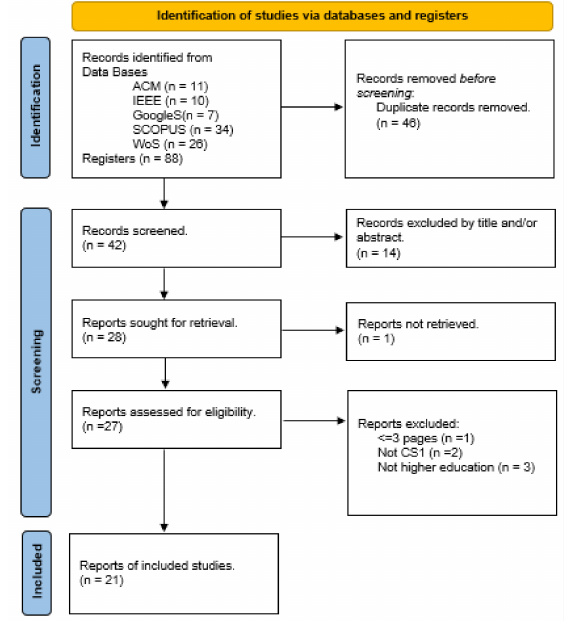
Figure 2. Study selection flow diagram (PRISMA diagram adapted).